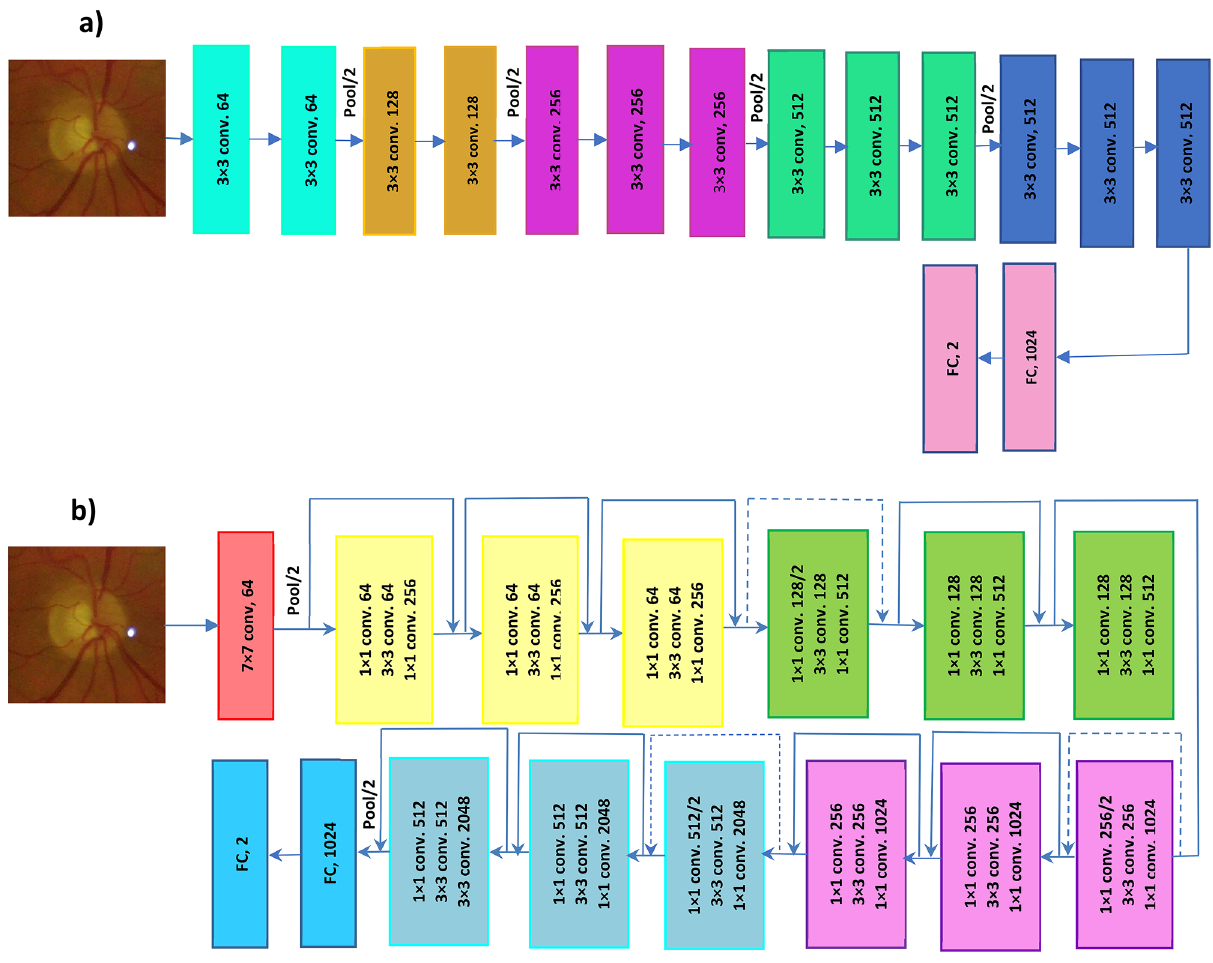
Figure 2. Overall framework of convolutional neural networks. ( a ) VGG16, ( b ) ResNet50.